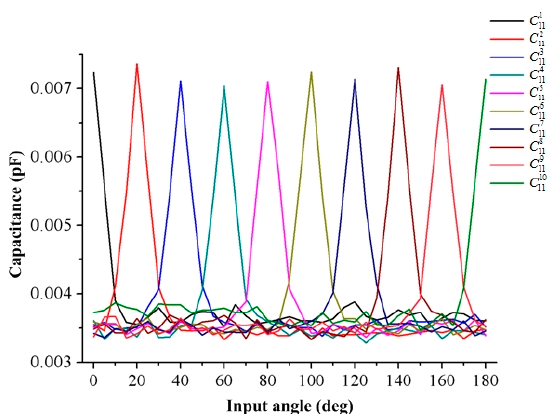
Figure 8. The amount of the mutual capacitance when the mercury droplet moves from Point A to Point B.